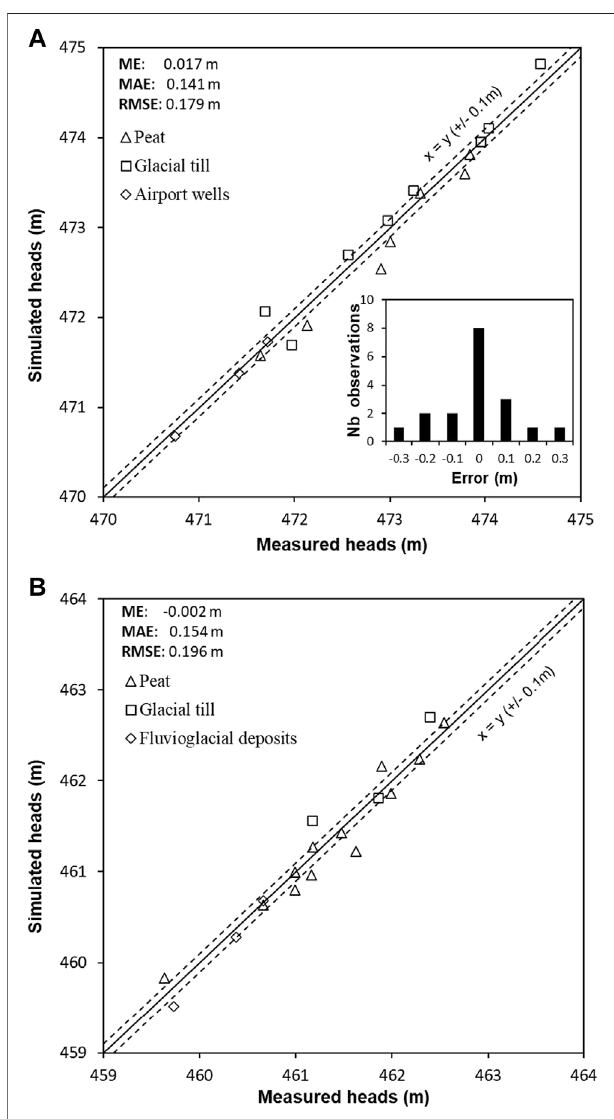
FIGURE 7 | Measured and simulated steady-state piezometric heads with associated error statistics for (A) the Misask peatland and (B) the Cheinu peatland. Dotted lines